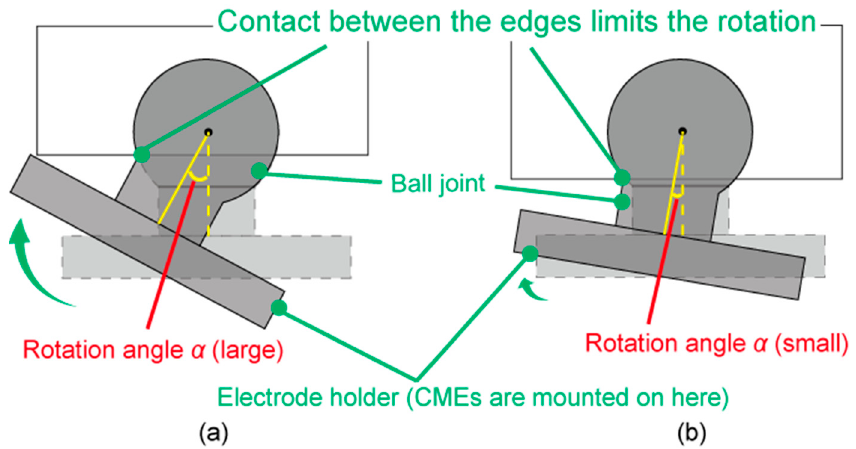
Figure 5. Images of the ball joint with ( a ) a large rotation angle α and ( b ) a small rotation angle α . The rotation stops when the edges of the ball joint hit the holder.